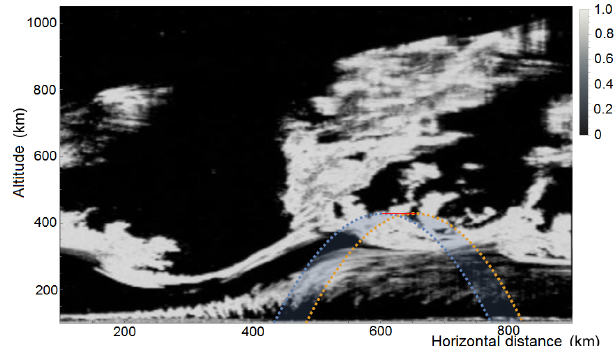
Figure 8. Rocket trajectory of the experiment conducted in Decem- ber 2012 superimposed over the color-inverted RTI map taken at Jicamarca in October 1993 (reproduced from Woodman and Chau, 2001). We assume that the shadowed region in faint blue represents the possible trajectories that may have had the rocket in a physical scenario similar to that measured at